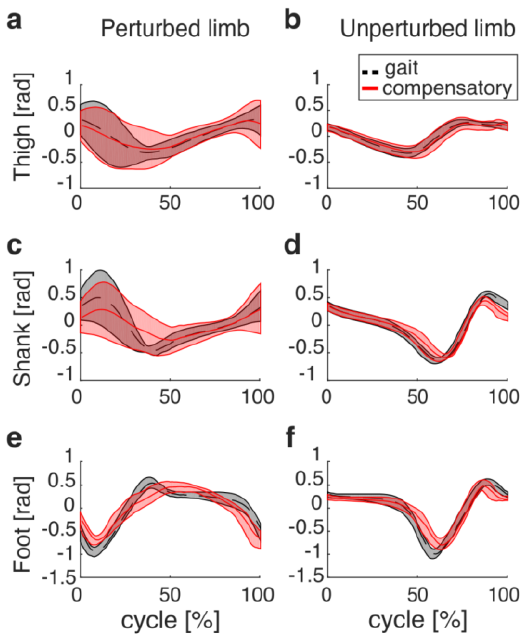
Figure 3. Elevation angles of the thigh, shank and foot recorded before (dashed black lines) and after (red lines) the perturbation onset. x -axes represent the time course (in %) of the gait and compensatory cycles; 0 and 100% correspond to two consecutive heel strikes of the left foot. Mean (bold) and one standard deviation (shaded areas) are shown for both the perturbed (( a ), ( c ) and ( e )) and unperturbed limb (( b ), ( d ) and ( f )) segments.